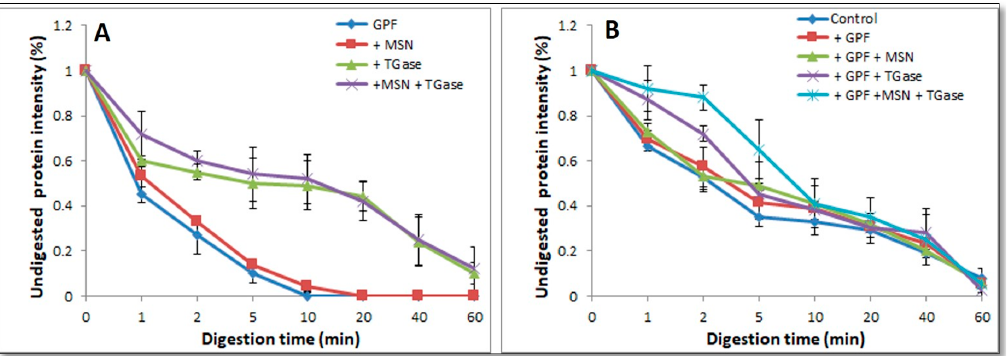
Figure 7. Intensity of the protein framed bands in gels of Figures 6 and 8, obtained after in vitro gastric digestion (IVD). Both grass pea flour (GPF)-based film forming solutions (FFSs) (Panel A ) and fried kobbah coated with all GPF-based FFSs (Panel B ), were subjected to densitometry analysis.